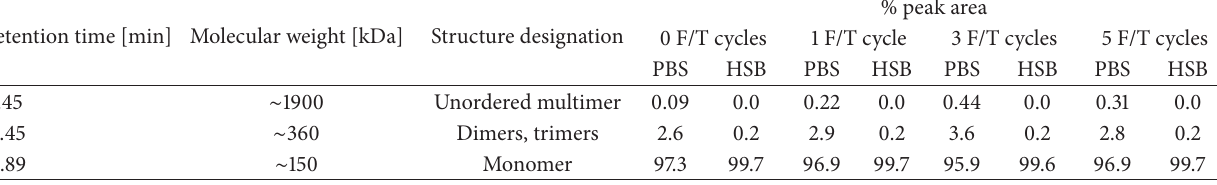
Table 1: Summary of ruthenylated antibody analysis by HPSEC. Ruthenylated antibody was stored at 1mg/mL in PBS) or in HSB. Each preparation was subjected to multiple freeze-thaw (F/T) cycles by cycling between −80 ± 10 ∘ C (approximately 16 hours) and 5 ± 3 ∘ C (approximately 8 hours) prior to analysis by HPSEC.